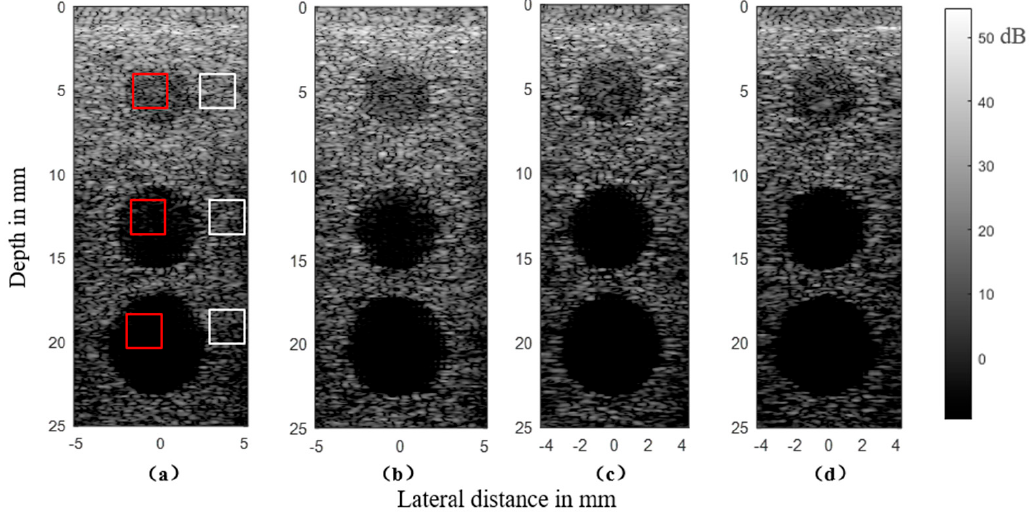
Figure 10. Simulation results of a cyst phantom from: ( a ) an MULA, ( b ) an MNULA with various kerfs, ( c ) an MNULA with various widths, and ( d ) an MNULA with various kerfs and widths.